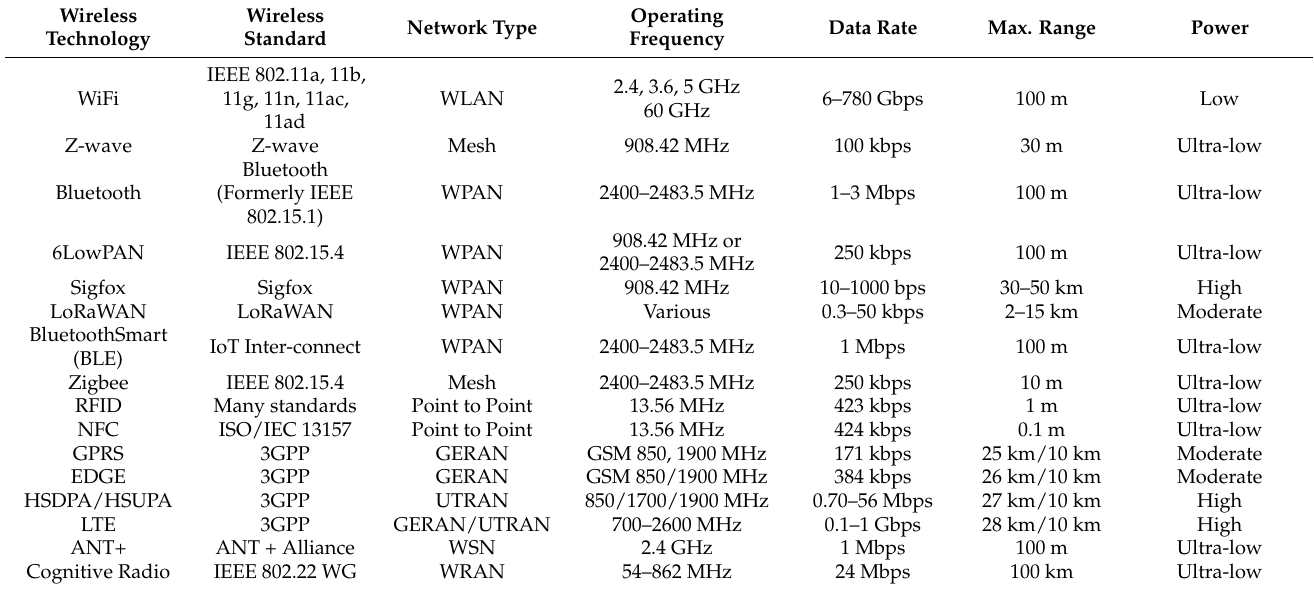
Table 1. Widely used IoT wireless